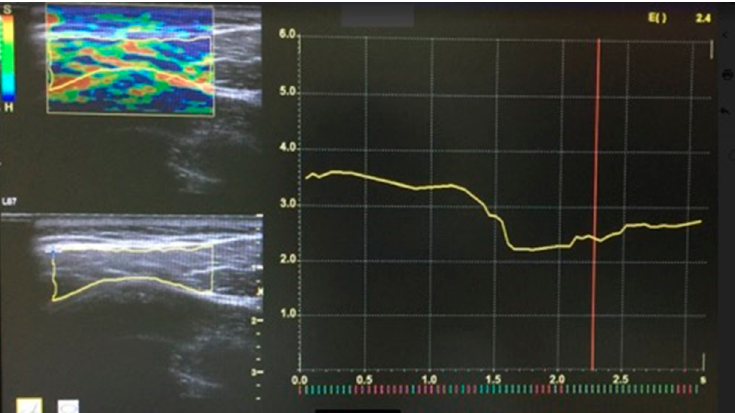
Figure 2. Sonoelastrogram of the upper trapezius muscle.